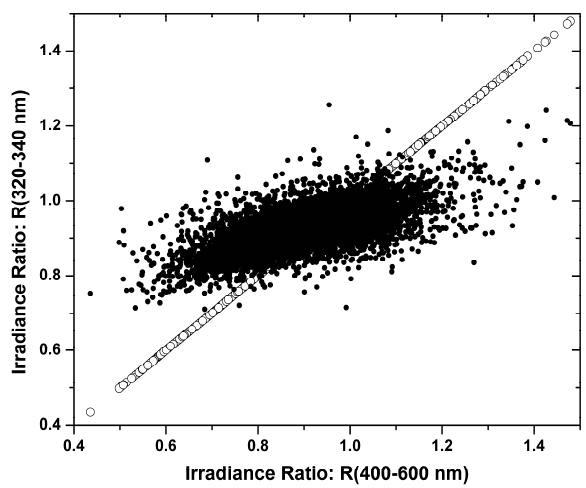
Fig. 6. Dark circles denote measured irradiance ratios for 320– 340nm plotted against those for 400–600nm, showing the wave- length dependence in the attenuation or enhancement in solar irra- diance associated with South Polar clouds. The straight line and squares indicate a hypothetical case of no wavelength